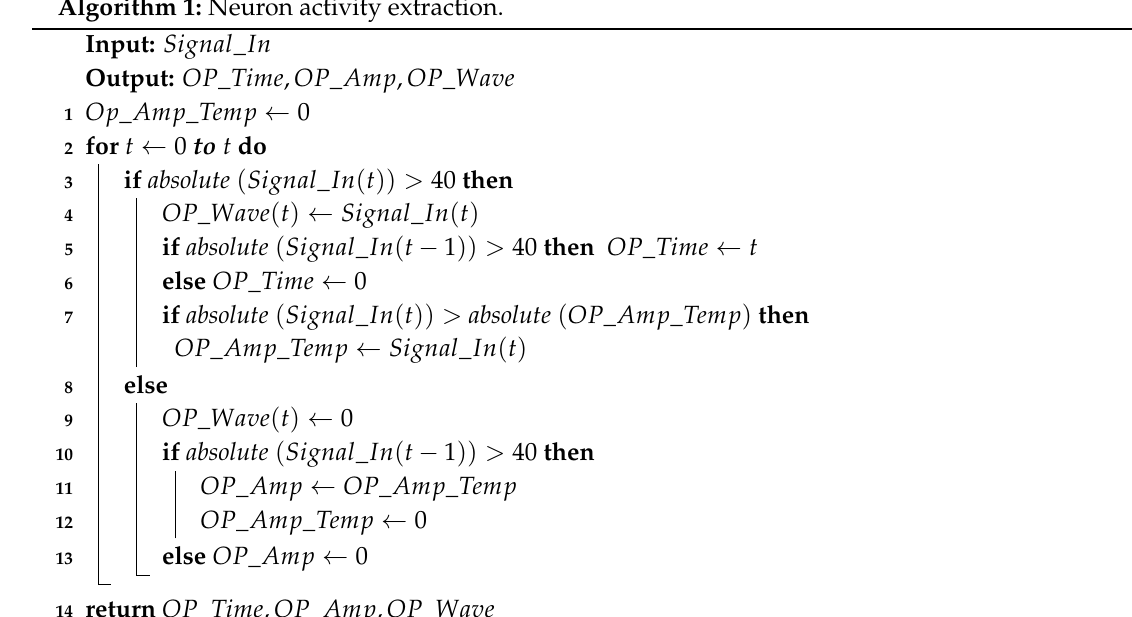
Figure 3. System architecture of the neuron activity extraction unit. Algorithm 1: Neuron activity